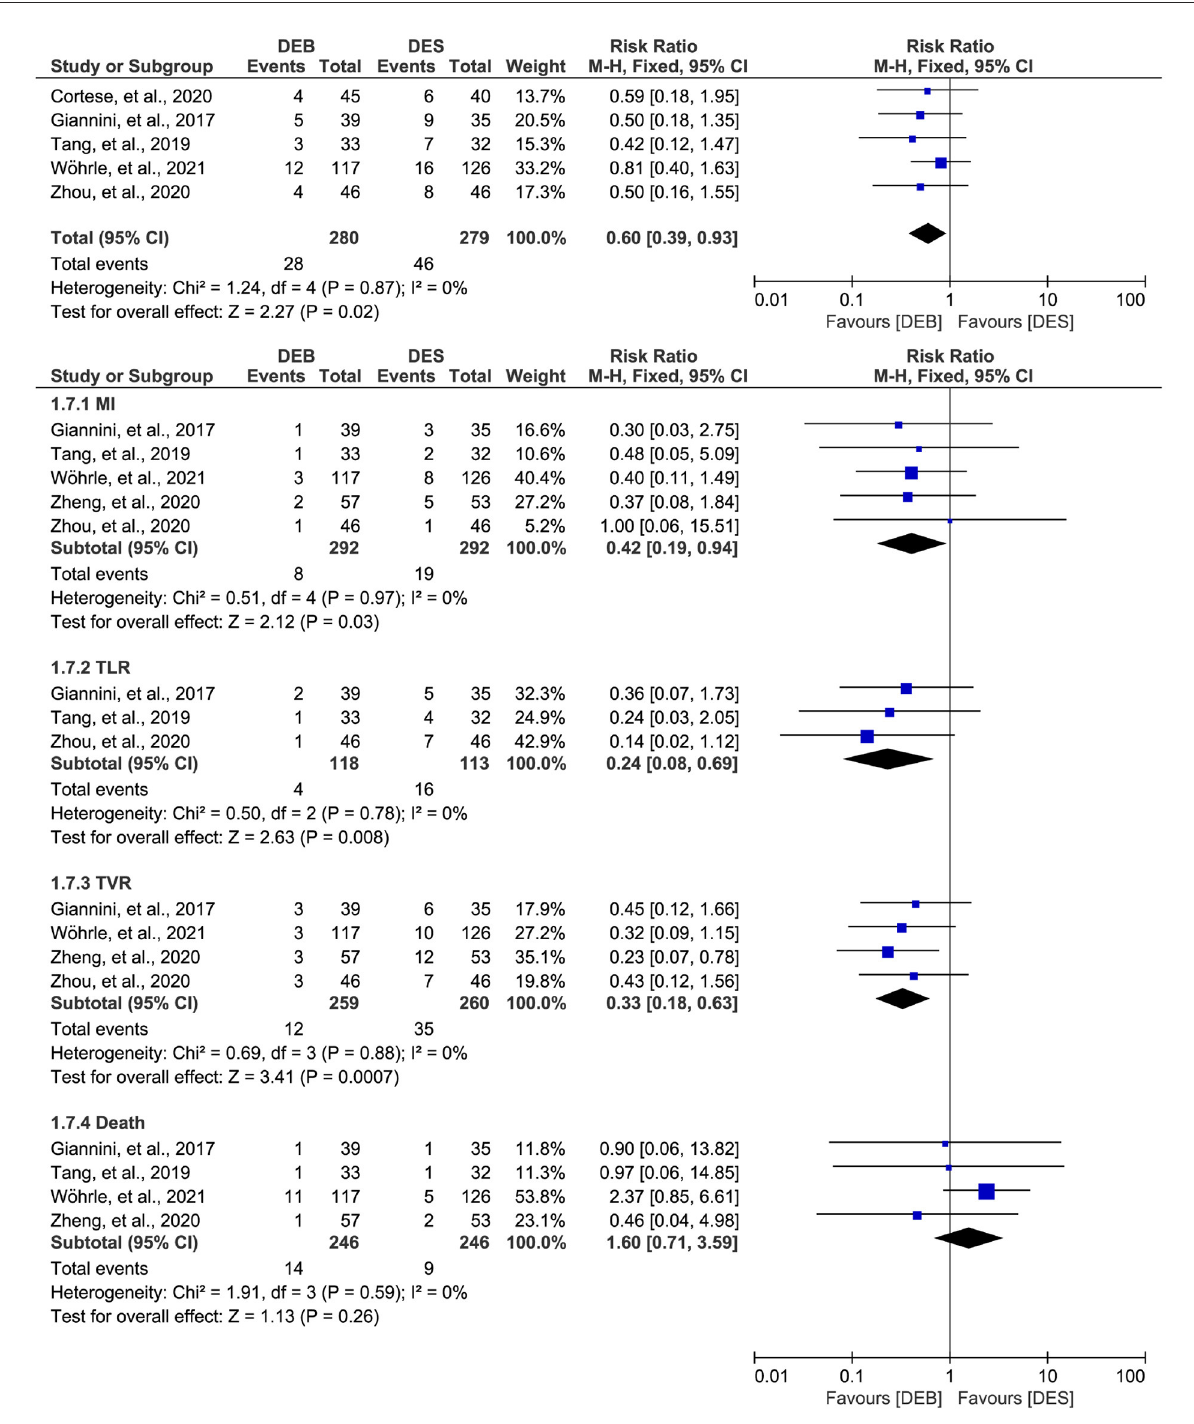
FIGURE3 Meta-analysis of the MACE outcome. The black diamond represents the pooled result. If the black diamonds are completely to the left of the null line (“1”), it means that DEB is better than DES in terms of MACE results, MI, TLR, TVR, and death; if the black diamonds are completely to the right of the null line (“1”), it means that DEB is inferior to DES in terms of all outcomes; and if the black diamonds crossed through the null line (“1”), it means that DEB is comparable to DES in terms of all outcomes. MACE, major adverse cardiac events; MI, myocardial infarction; TLR, target lesion revascularization; TVR, target vessel revascularization; DCB, drug-eluting balloon; DES, drug-eluting stent; M-H,